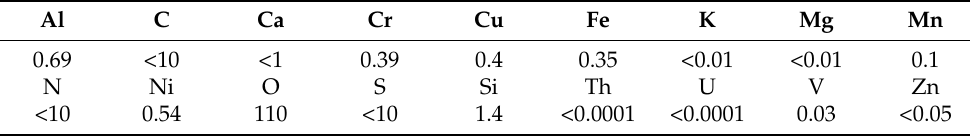
Table 1. Nominal composition of titanium sample with mass purity of 99.98% (mass